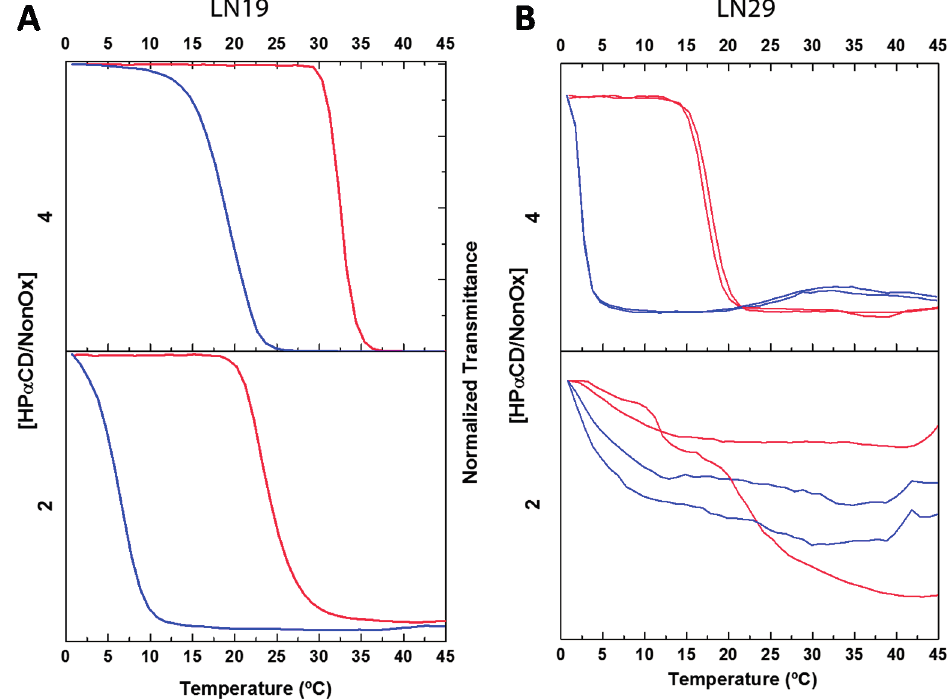
Figure 8. Turbidimetry studies of 5 mg·mL − 1 solutions of P[(EtOx) 162 - ran -(NonOx) 38 ] ( A , LN19) and P[(EtOx) 140 - ran -(NonOx) 57 ] ( B , LN29) with increasing HP α CD/NonOx molar ratios. Large HP α CD excesses are required to solubilize both copolymers, especially in the case of LN29. The heating and cooling ramps are represented by the top (red) and bottom (blue) curves, respectively. Rate: 1 K·min − 1 , λ = 700